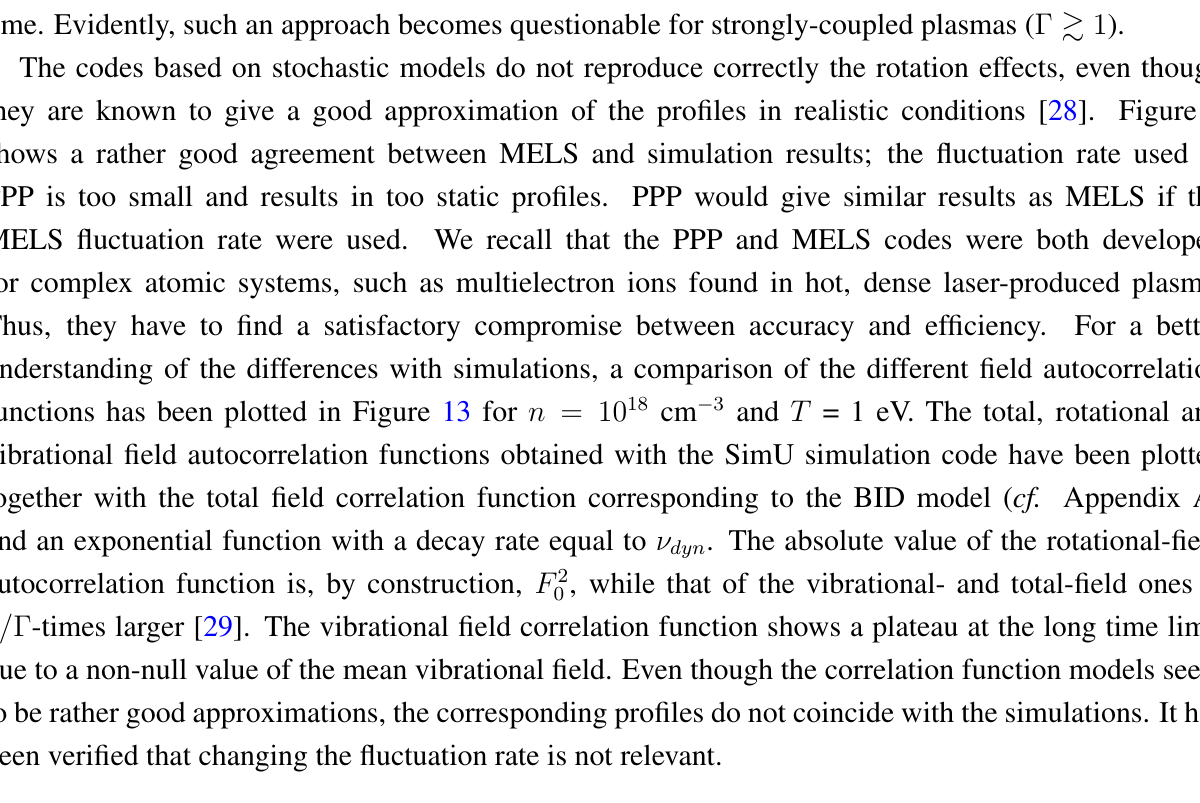
Figure 13. Autocorrelation functions of the total (black line), rotational (green line) and vibrational (red line) fields compared to the BID model correlation function (dashed blue line) and the exponential function corresponding to the FFM model (short dashed blue